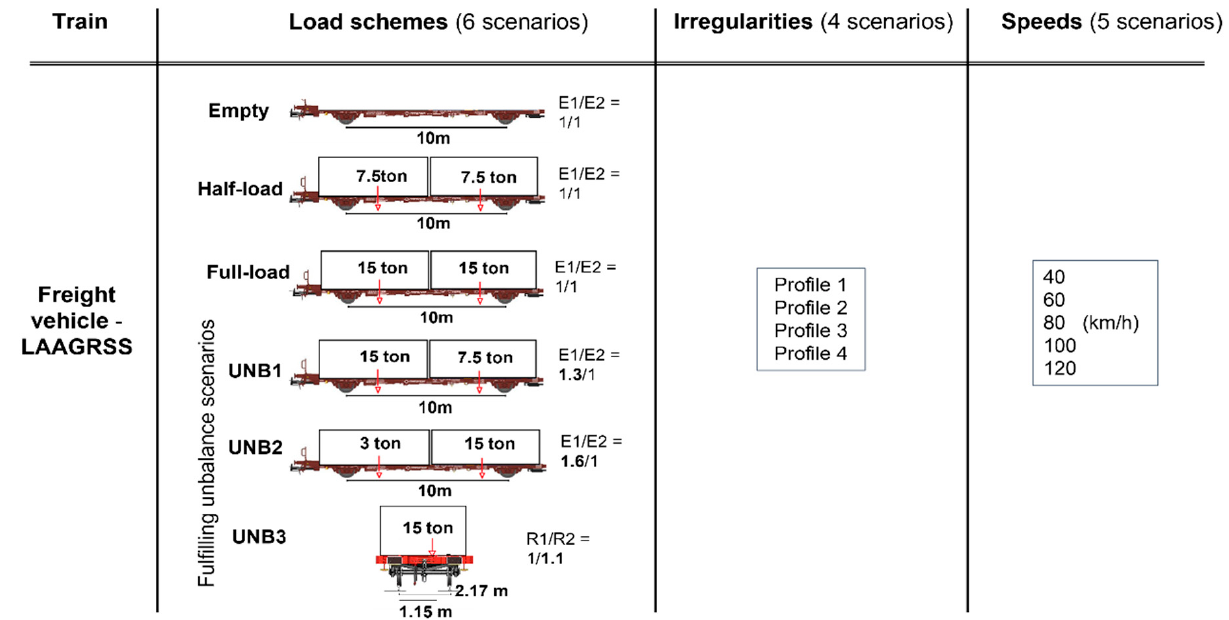
Figure 3. Baseline scenarios.